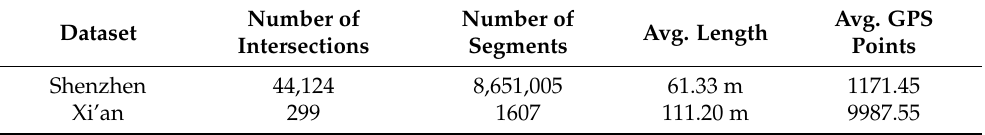
Table 1. Statistics of the two road network datasets.